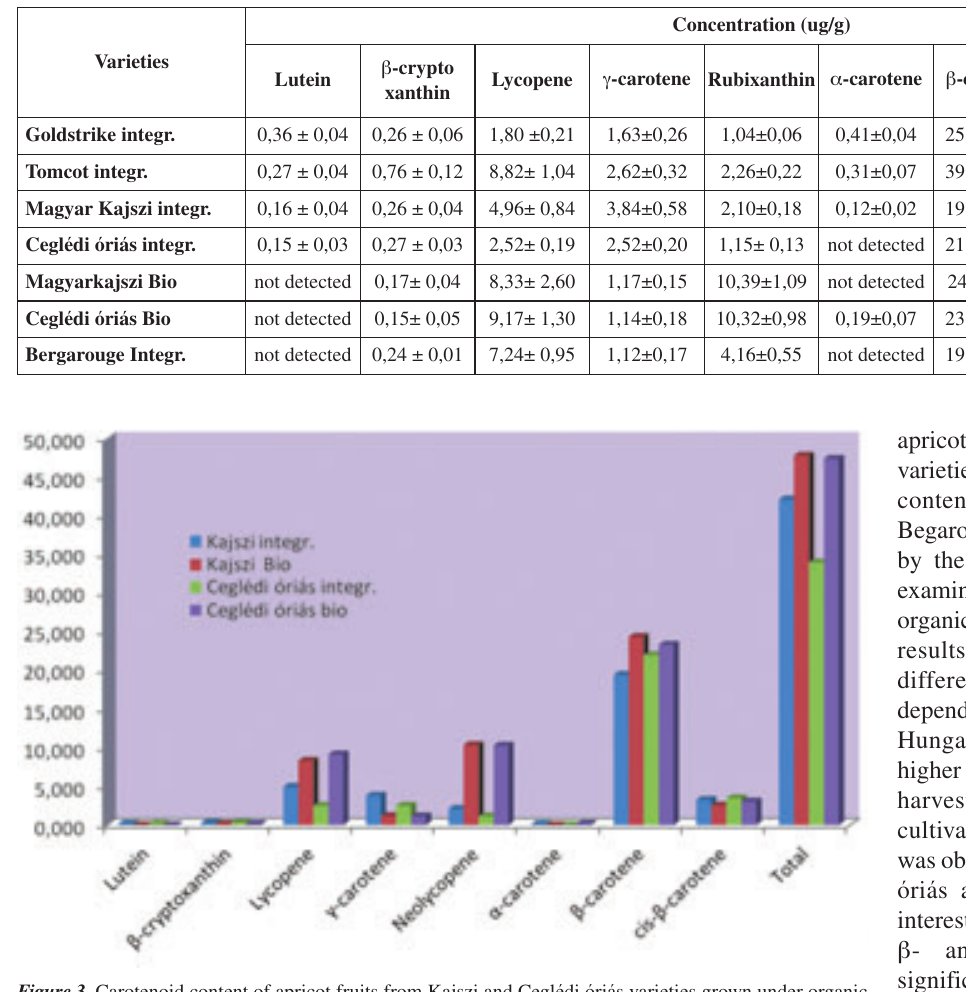
Figure 3. Carotenoid content of apricot fruits from Kajszi and Ceglédi óriás varieties grown under organic and integrated cultivation conditions.